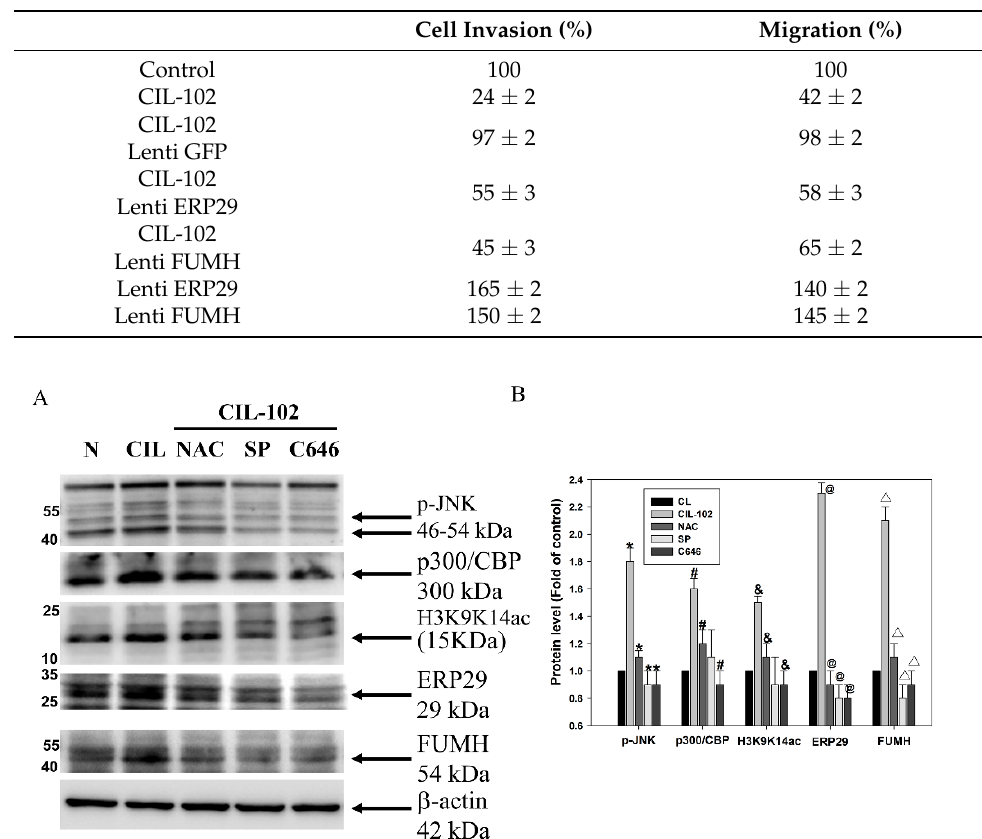
Table 2. Effects of the kinase inhibitor on the CIL-102 induction associated with cancer cell aggressive status in DLD-1 cells.